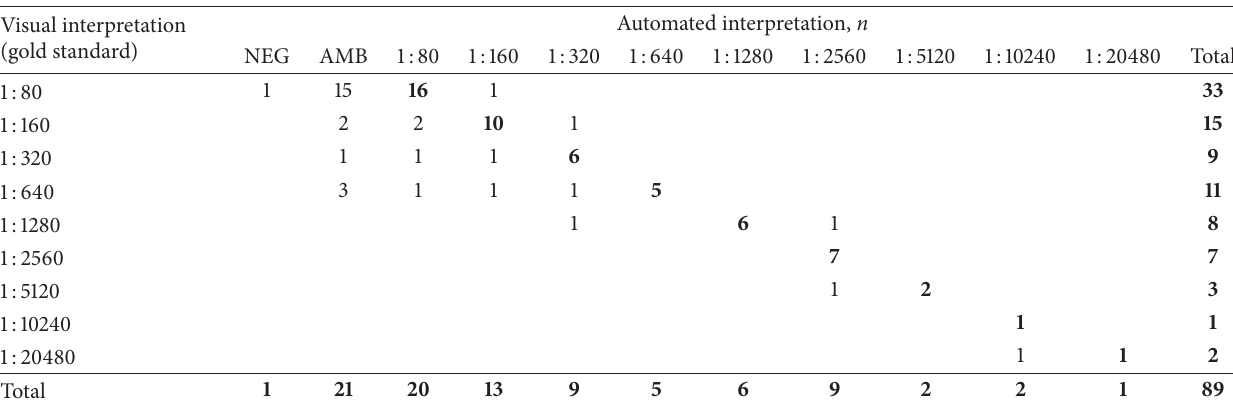
Table 2: Visual versus automated detected titres of antinuclear antibodies by indirect immunofluorescence. Crosstabulation of antinuclear antibodies (ANA) titres by indirect immunofluorescence (IIF) for 89 serum samples that revealed a positive result by visual interpretation of the ANA-IIF-assay 2; concordant results are shown in bold (NEG: negative; AMB: ambiguous).